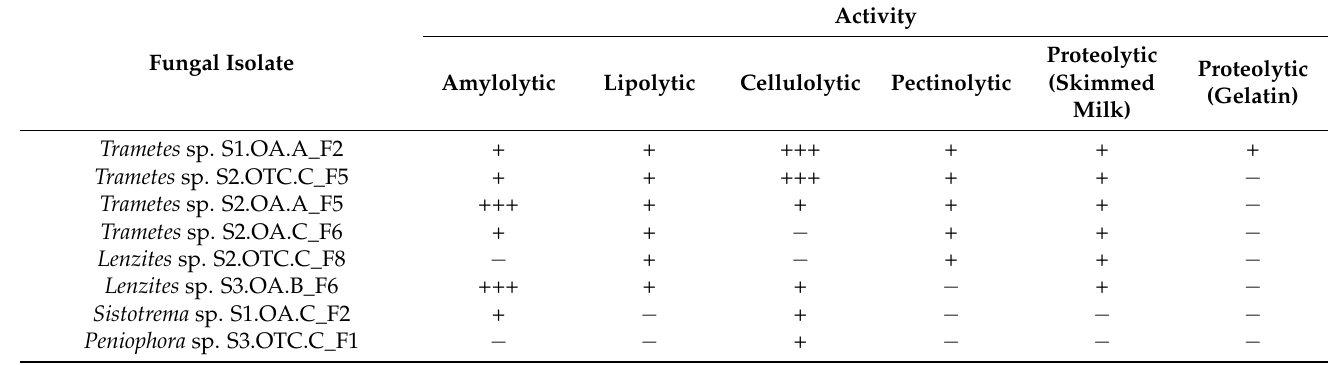
Table 1. Screening for extracellular enzymatic activities of newly isolated Antarctic fungal isolates. Qualitative extracellular enzyme activity was determined by the appearance of haloes (diameter in mm) around the colony as follows: − , no halo; +, 5–20 mm halo; +++, ≥ 30 mm